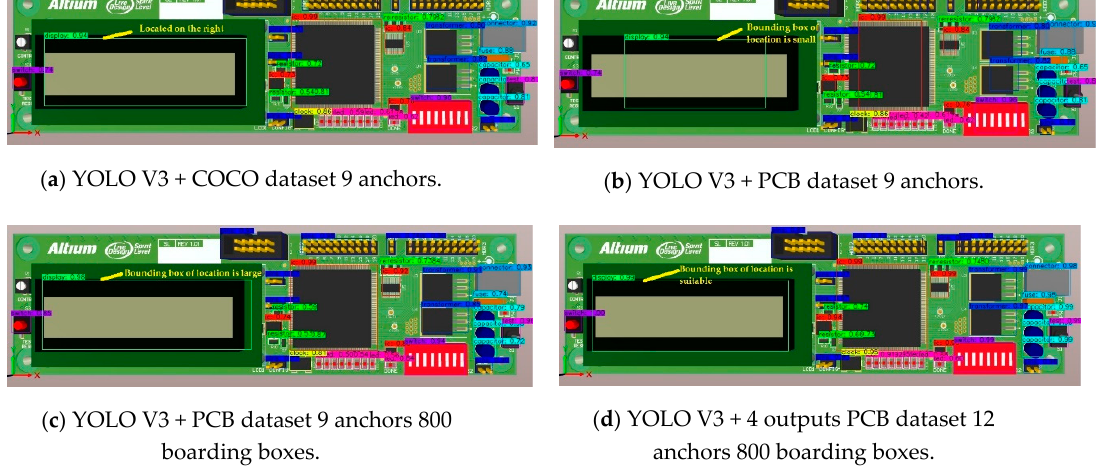
Figure 11. Comparisons of object detection results on virtual image between the four algorithms.